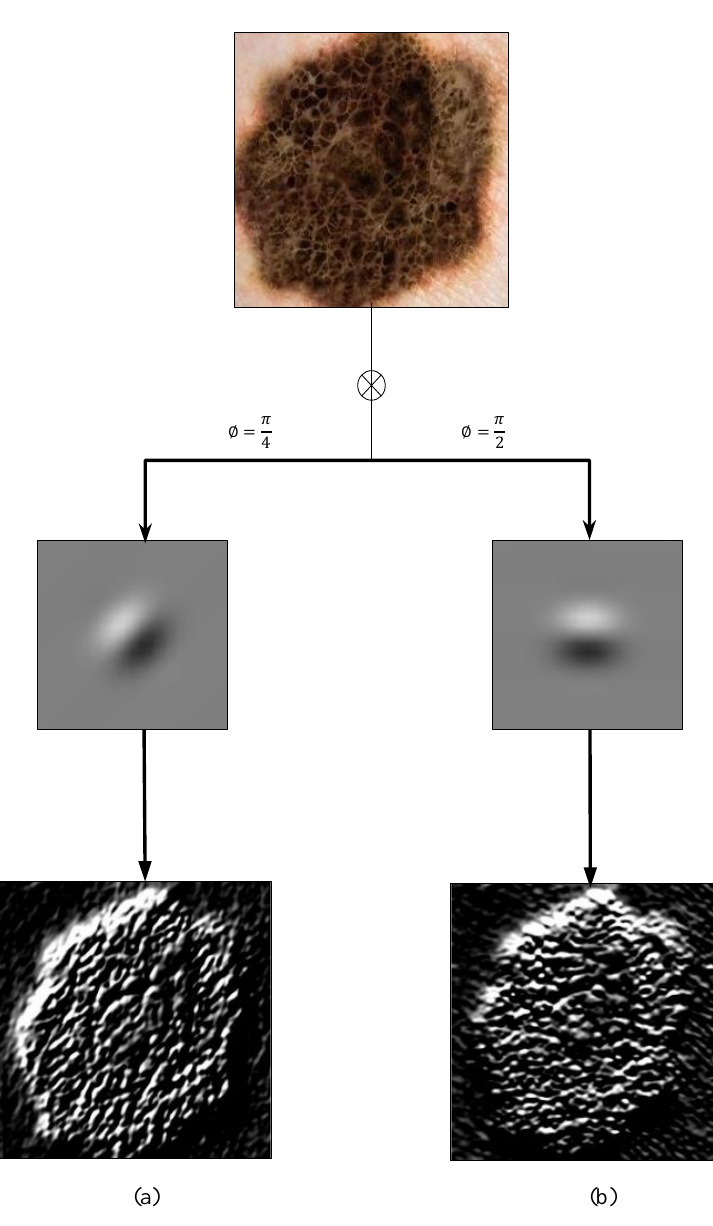
Figure 4. Gabor filter responses of a sample skin lesion at orientation angles of ( a ) π